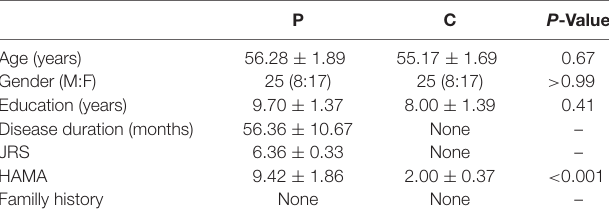
TABLE 1 | Demographic and clinical characteristics of patient group and control